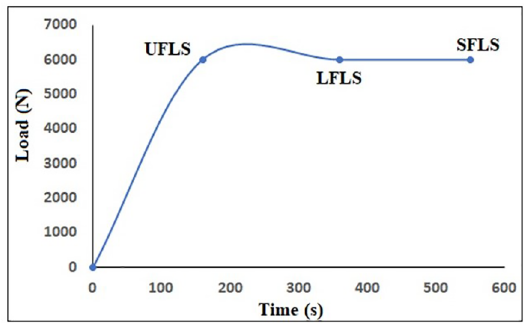
Figure 5. Effect of fiber length on load Vs Time.